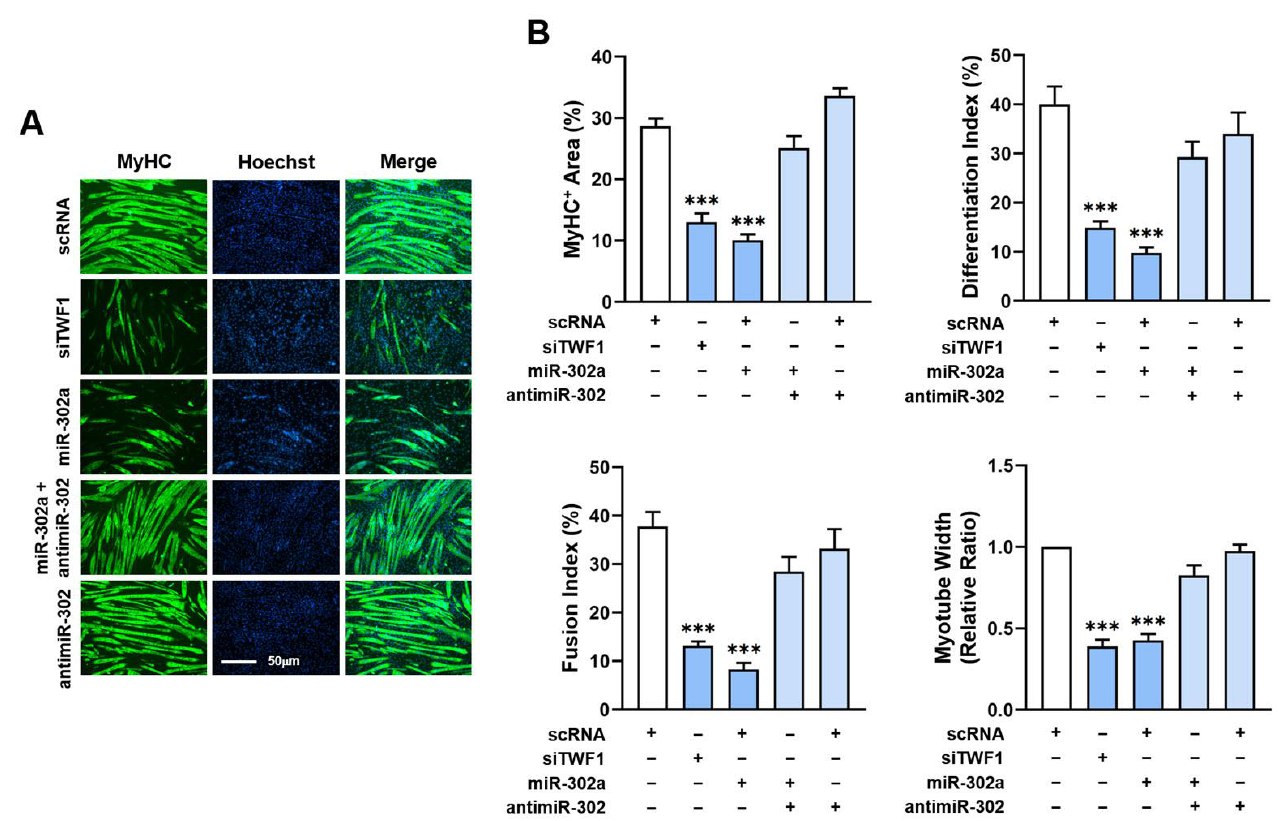
Figure 6. MiR-302a impairs myogenic differentiation. C2C12 cells were transfected with scRNA, siTWF1, miR-302a mimic, or antimiR-302 and differentiated for 5 days. ( A ) Immunofluorescence staining for MyHC (MF20, green) and nucleus (Hoechst 34452, blue) on differentiation day 5. Scale bar: 50 μm. ( B ) Myogenic differentiation was analyzed using MyHC-positivity areas, differentiation and fusion indices, and myotube widths. Values are relative ratios versus controls (scRNA). Results are presented as means ± standard errors ( n > 3); ***, p < 0.001 vs. scRNA.